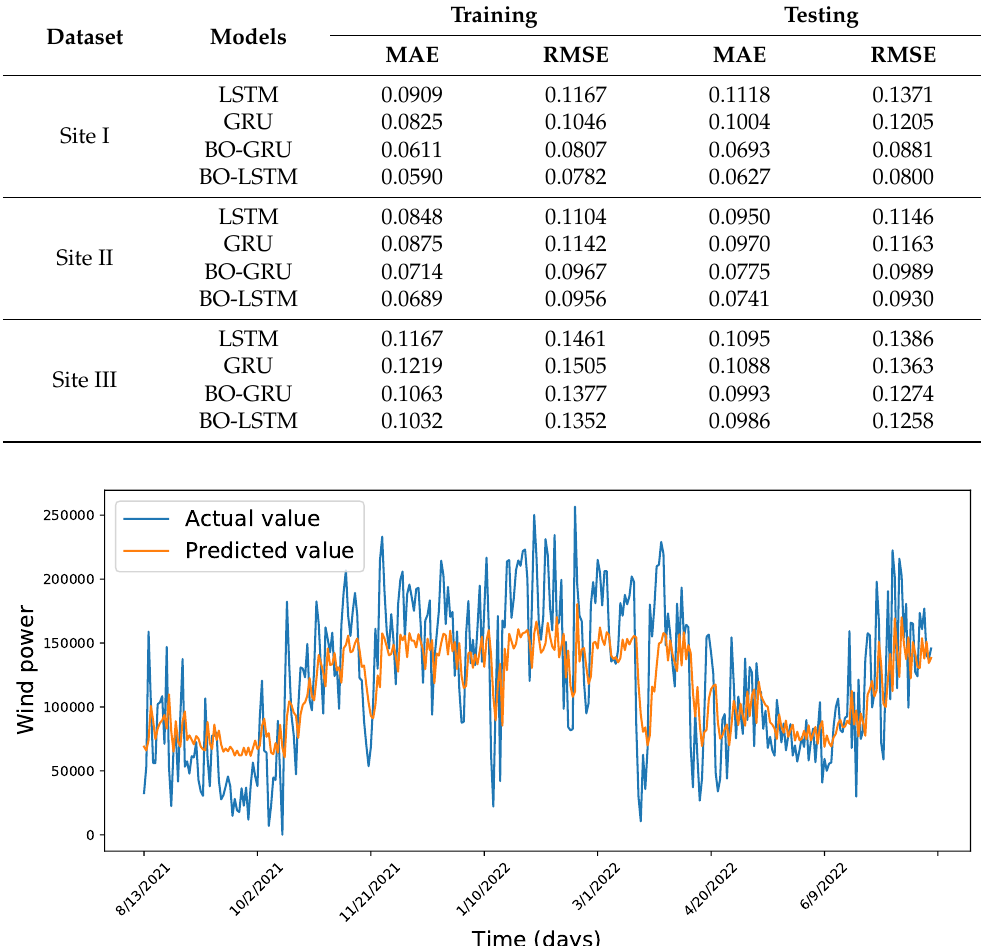
Table 4. Forecasting performances of competitive deep learning models on training and test data.